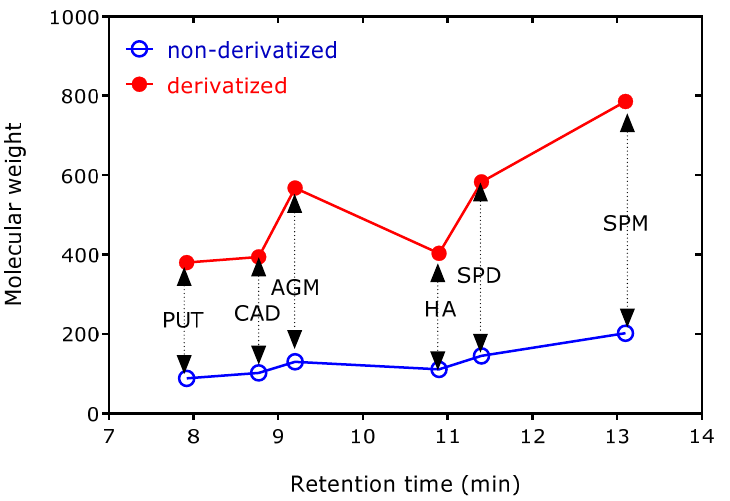
Figure 4. Relationship between the molecular weight of the indicated derivatized and non-derivatized amines. EA and OTP40 were used as the extraction solvent and the GC oven temperature program (starting oven temperature, 40 °C). PUT, putrescine; CAD, cadaverine; AGM, agmatine; HA, histamine; SPD, spermidine; SPM, spermine.